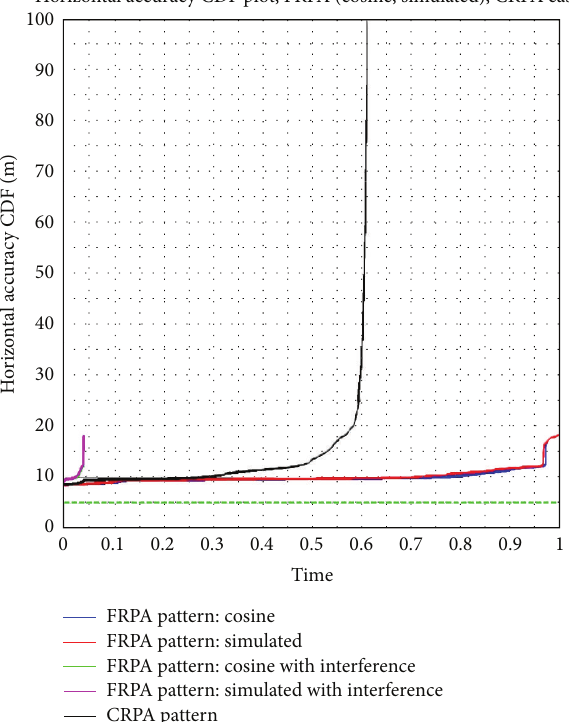
Figure 23: Horizontal accuracy CDF curve − 24/24 GPS constella- tion and 6RF interfering